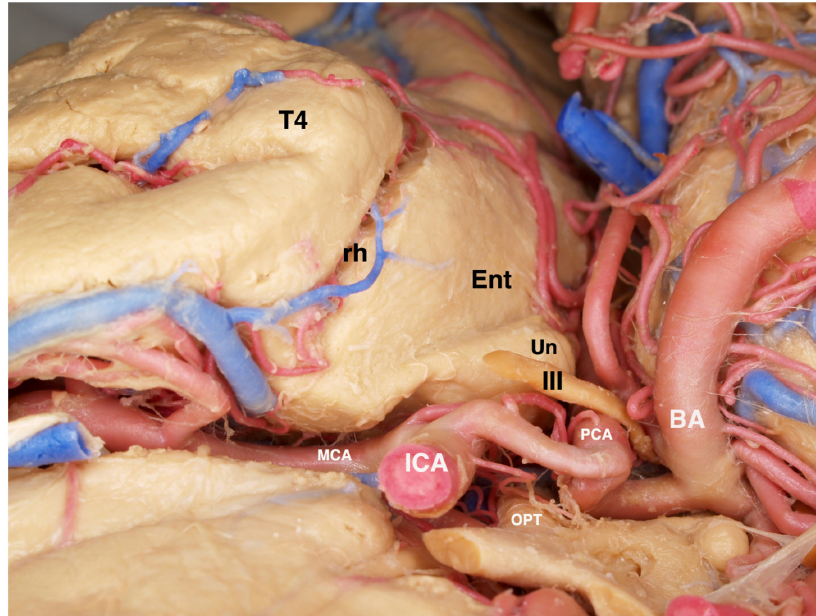
Figure 8. View of a fixed and injected brain from the orbital frontal surface looking posteriorly. The normal relationships of structures lying adjacent to the mesial temporal lobe are visualized. The 3rd cranial nerve is normally abutting the pia of the anterior uncus. The posterior cerebral artery can be recognized along its course beneath the transparent pia of the uncus and the parahippocampus. The close association of the ICA and its bifurcation with the uncus and amygdala are illustrated. T4 = fusiform gyrus of the temporal lobe, rh = rhinal sulcus, Ent = entorhinal cortex (most anterior extent of the parahippocampus), Un = uncus, III = oculomotor cranial nerve, ICA = internal carotid artery, PCA = posterior cerebral artery, OPT = optic chiasm, BA = basilar artery, MCA = middle cerebral artery. Brain Sci. 2018 , 8 , x FOR PEER REVIEW